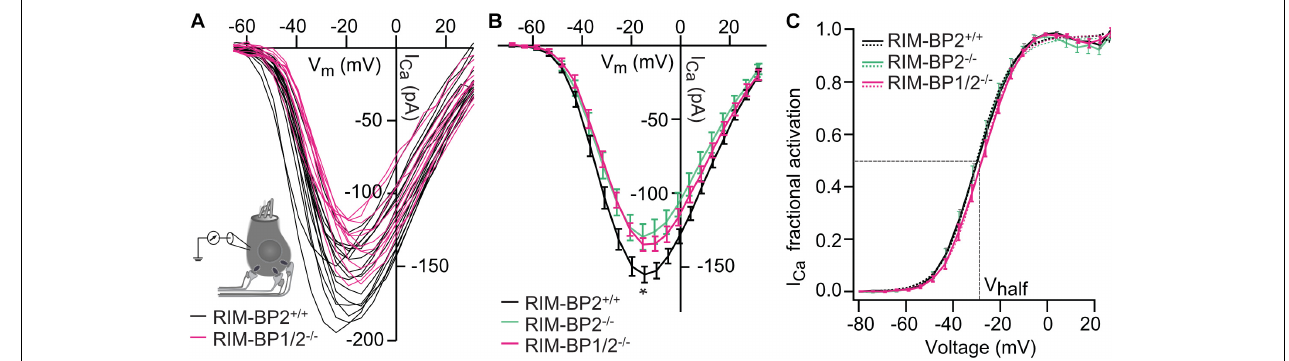
FIGURE 1 | Additional RIM-BP1 disruption does not alter voltage-dependent Ca 2 + -influx. (A) Schematic drawing of an IHC during perforated patch-clamp experiment and raw traces of Ca 2 + -current-voltage relationships (IVs) of RIM-BP1/2-deficient ( RIM-BP1/2 − / − , magenta) and control ( RIM-BP2 + / + , black) IHCs. IVs were calculated from the last 8 ms of currents evoked by step depolarizations to various potentials. (B) Mean ± SEM from IVs of RIM-BP1/2-deficient ( RIM-BP1/2 − / − , n = 15, magenta), RIM-BP2-deficient ( RIM-BP2 − / − , n = 16, green) and control ( RIM-BP2 + / + , n = 17, black) IHCs in panel (A) . Compared to control IHCs, Ca 2 + -current amplitudes were significantly reduced in RIM-BP1/2-deficient IHCs ( p = 0.02). However, no significant difference was found between RIM-BP1/2-deficient and RIM-BP2-deficient IHCs. (C) Fractional activation curves of the whole-cell Ca 2 + -current: A Boltzmann function was fit to the normalized conductance curve (C) calculated from the IVs (A) . Average fit data are displayed for all three genotypes (dashed traces : RIM-BP1/2 − / − , n = 15, magenta, RIM-BP2 − / − , n = 16, green and RIM-BP2 + / + , n = 17, black). Dashed vertical line indicates V half , reporting the voltage of half-maximal activation of the